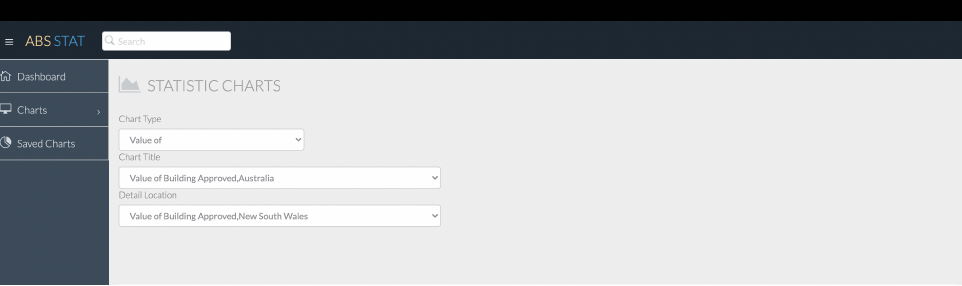
Figure 2. Three-level navigation.